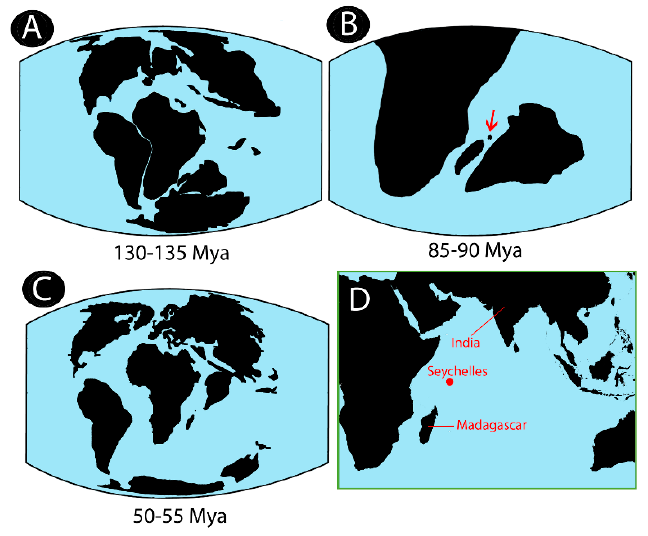
Figure 11. Illustration of key steps for Notopteridae biogeography: ( A ) Split of India from the Gondwana continent; ( B ) Geographic distribution of Seychelles–India–Madagascar–Africa; ( C ) Arrival of India subcontinent to Eastern Asia; ( D ) Actual location of Seychelles, India, and Madagascar.